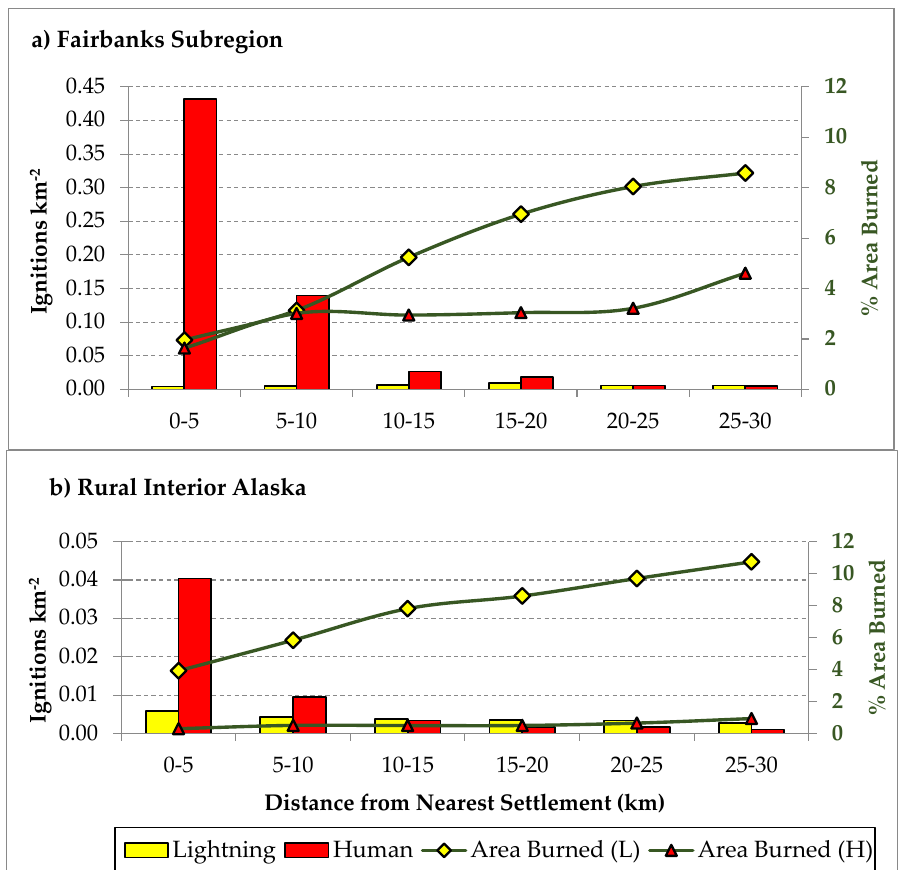
Figure 4. Number of fire ignitions (km −2 decade −1 ) and area burned (% decade −1 ) by cause from 1988 to 2016 with distance (km) from all named settlements in ( a ) the Fairbanks subregion; and ( b ) rural interior Alaska. In order to simplify comparisons across publications with different date ranges, we converted ignition density and area burned into decadal averages; e.g., within 0–5 km of settlements in the Fairbanks subregion, there were 0.43 human ignitions km −2 decade −1 which burned a total of 1.6% decade −1 of the area at that distance.